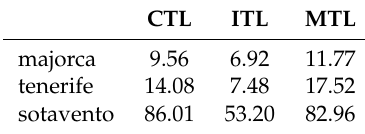
Table 8. Training time in seconds of the CTL and best ITL and MTL models for each